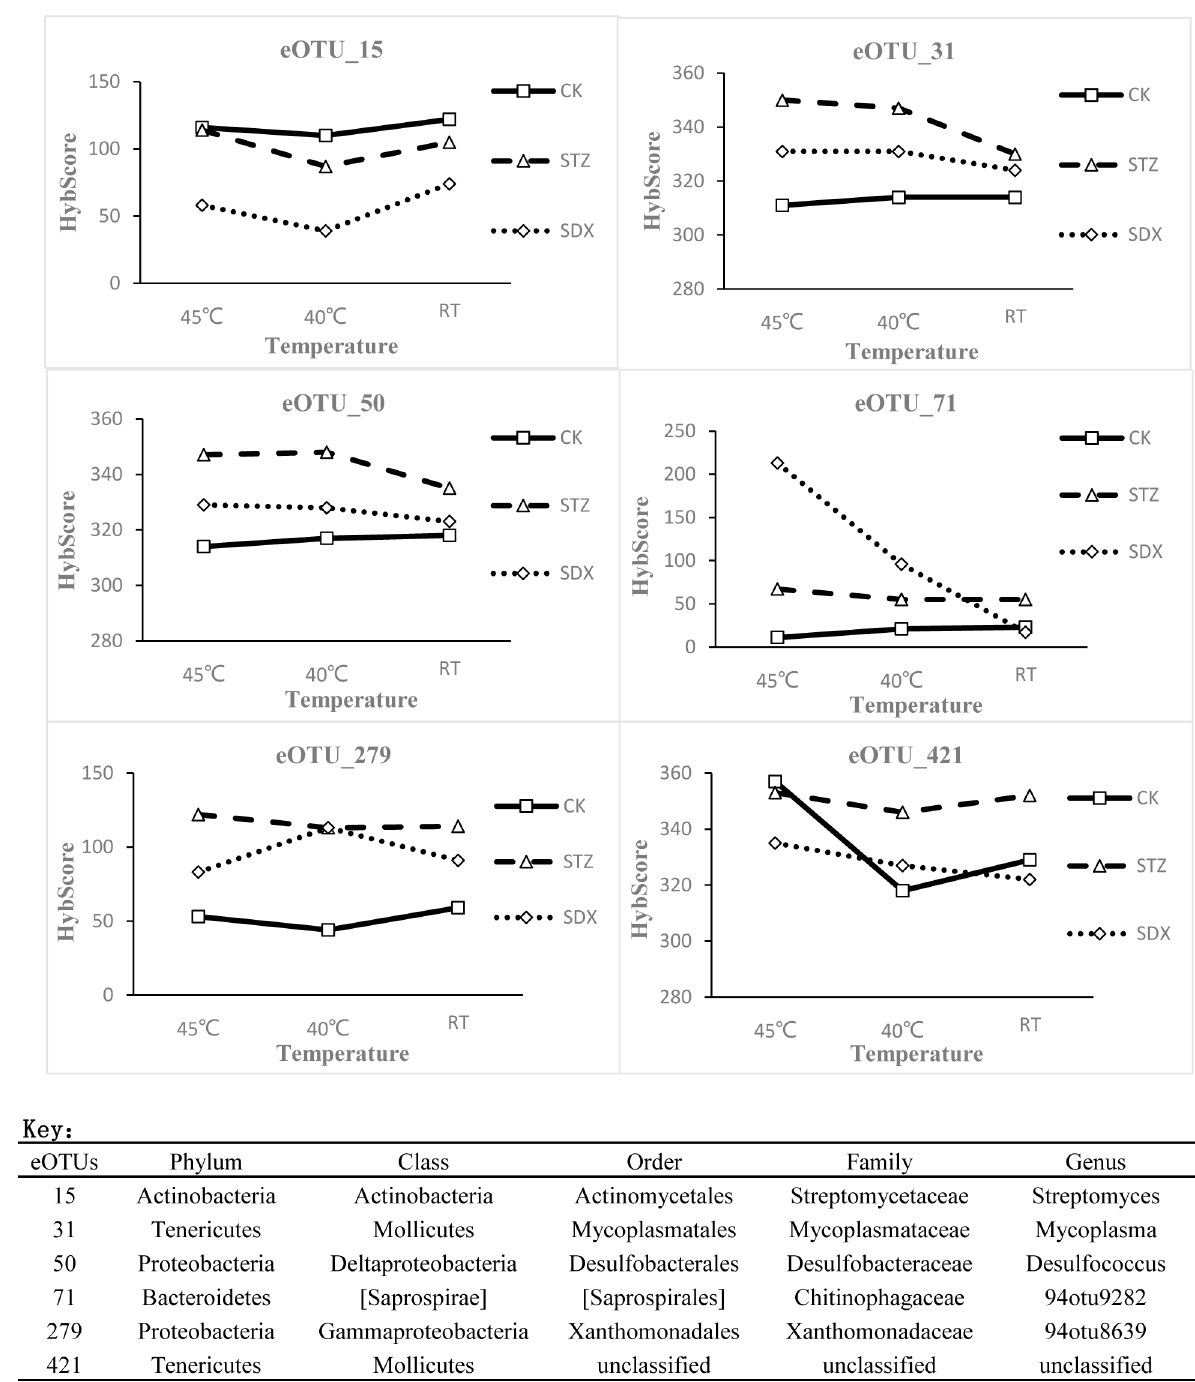
Fig 4. Phylochip TM G3 Hybscore for six specific operational taxon units (eOTUs) in leaf samples of HLB-affected citrus treated with different chemicals (Tap water (CK), STZ, and SDX) combined with thermotherapy at various temperatures (RT, 40°C and